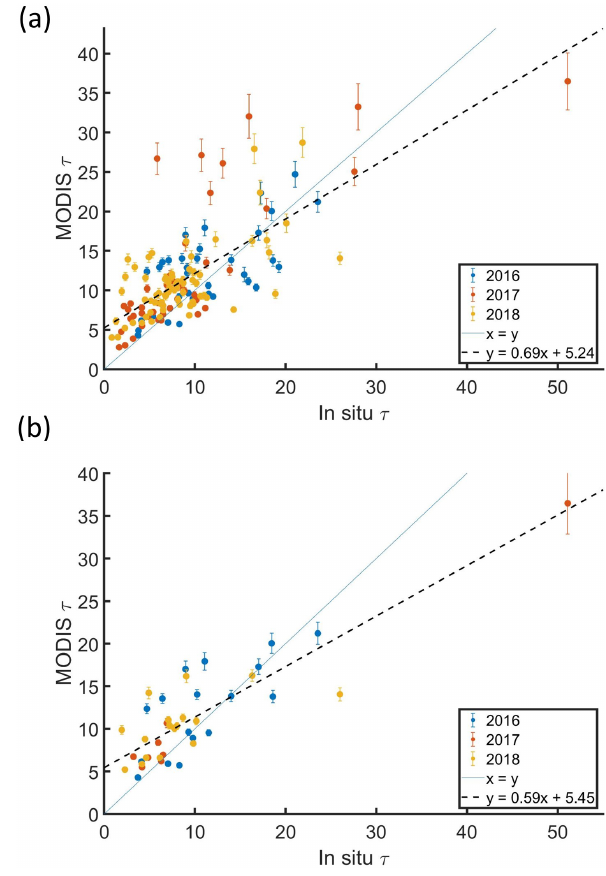
Figure 8. MODIS τ versus in situ τ for profiles with a MODIS retrieval co-located with in situ data for (cid:49)T (a) less than 3600s and (b) less than 900s, colored by ORACLES deployment year. Each point represents a cloud profile with the MODIS τ averaged over a 5 × 5 pixel